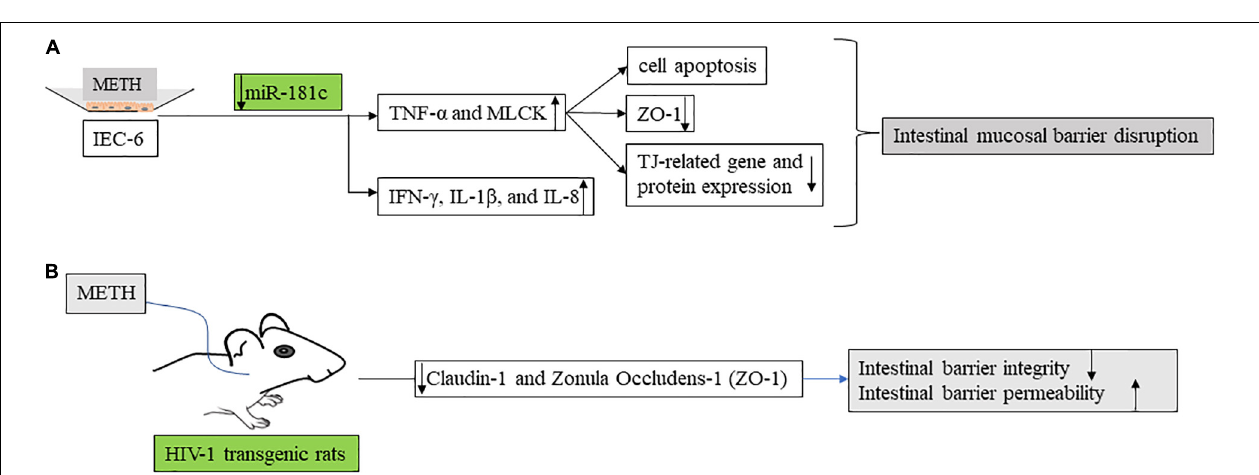
FIGURE 3 | The effects of methamphetamine on intestinal barrier function. (A) In in vitro model, methamphetamine regulates Mir-181c. Anti-mir-181c promotes the secretion of TNF- α and MLCK, resulting in increased intestinal barrier permeability (decreased tight junction related protein) and epithelial cell apoptosis. IEC-6 is a well-established rat cell line with characteristics similar to those of intestinal epithelial cells and is extensively used as a surrogate for intestinal epithelial cells, for in vitro studies. MLCK, myosin light chain kinase. (B) Self-administered methamphetamine resulted in decreased colonic barrier function [Claudin-1 and Zonula occludens-1 (ZO-1)] and impaired colonic integrity in HIV-1 transgenic